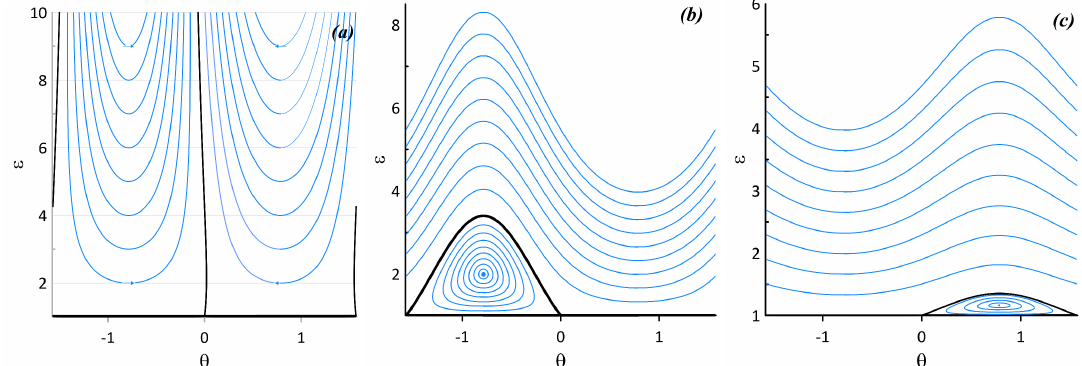
Figure 12. Phase portraits of the ellipsoid vortex motion corresponding to Regimes: ( a ) 1 ( e = 0.4 and